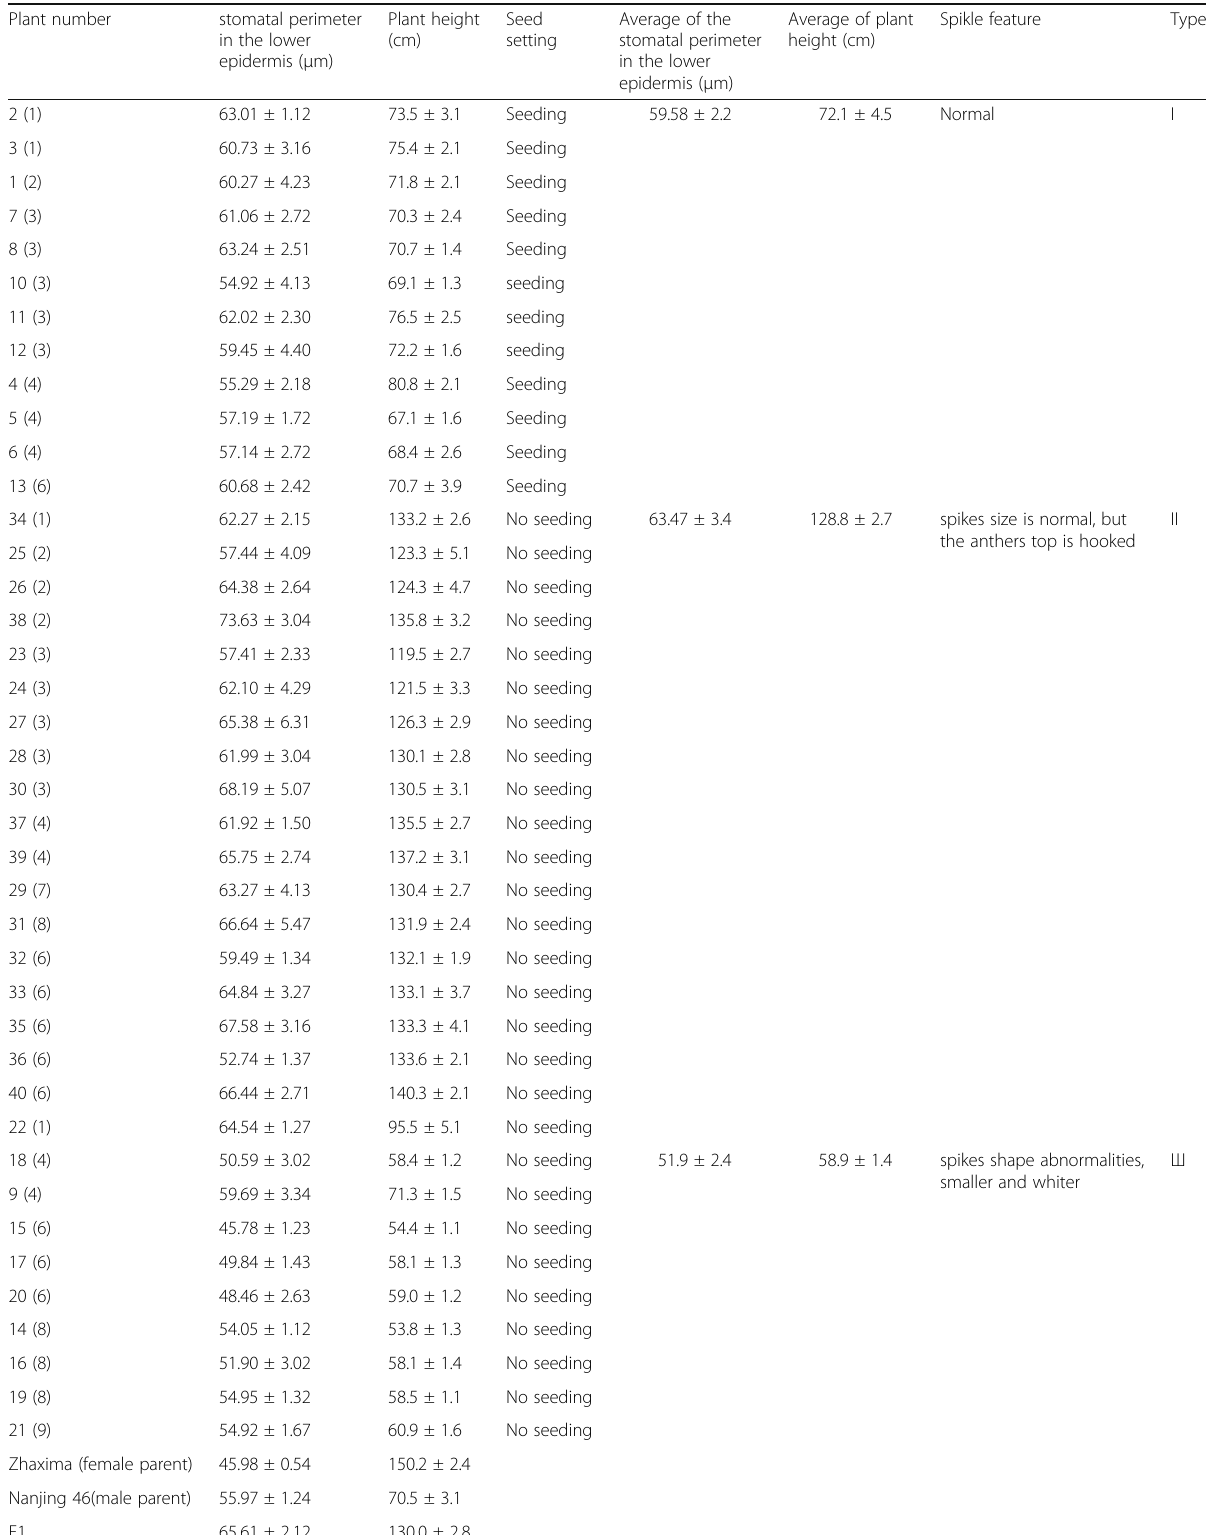
Table 4 External peripheral long of the stoma, stem length and the seed rate in regeneration plants from anthers Plant